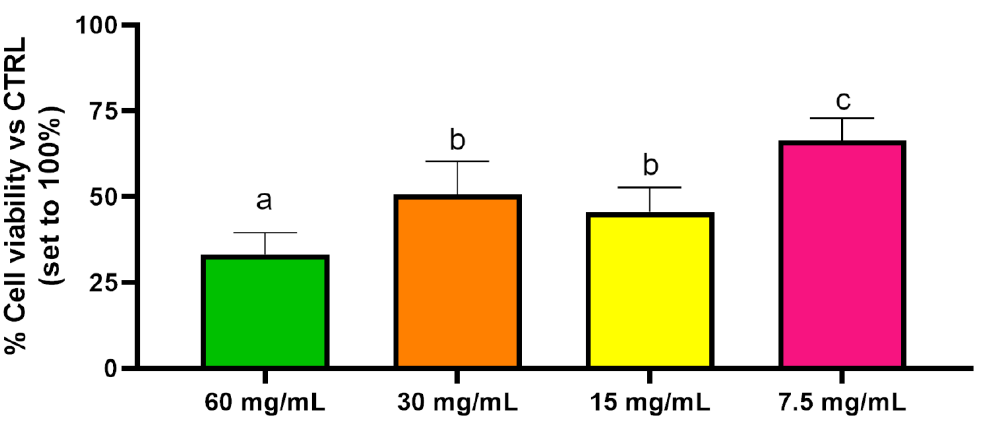
Figure 15. Cell viability evaluation of Balb/3T3 clone A31 cultured with several concentrations of TEGMA- ran -FA for 24 h. Not-shared letters indicate statistically significant differences, p < 0.05.